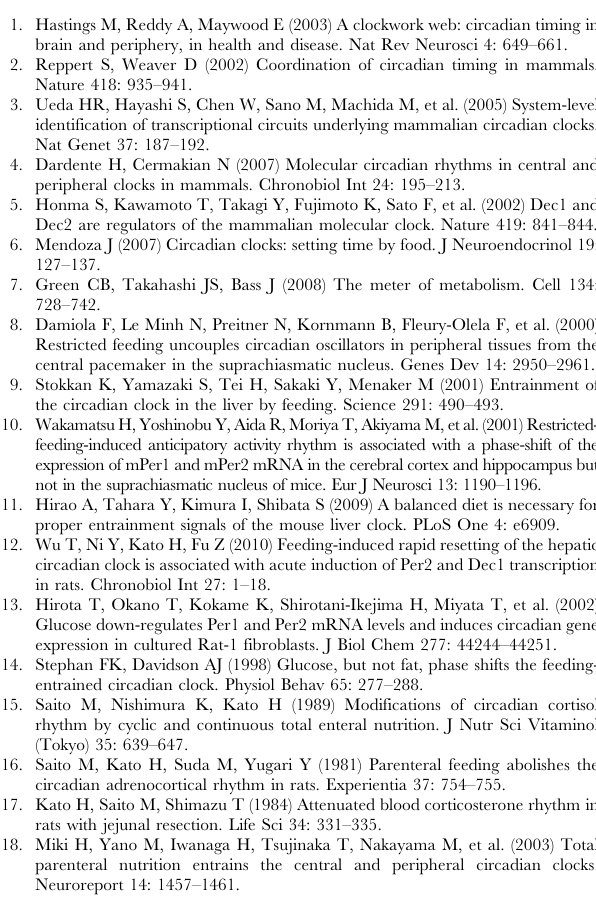
(TIF) Figure S3 Intraperitoneal injection of nutrients delays phase of liver, but not lung clock. (A) Experimental design. BALB/c mice fasted overnight and then were intraperitoneally injected with nutrients (12AA + Glc) or PBS (control) at ZT1. All animals were sampled at next day ZT2, 5, 8, and 11. (B and C) Temporal expression of Rev-erb a and Dbp mRNA in liver (B) and lung (C) is shown as means 6 SEM (n= 3, * p , 0.05, ** p , 0.01 Student’s t-test). Table S1 Gene expression data in DNA microarray